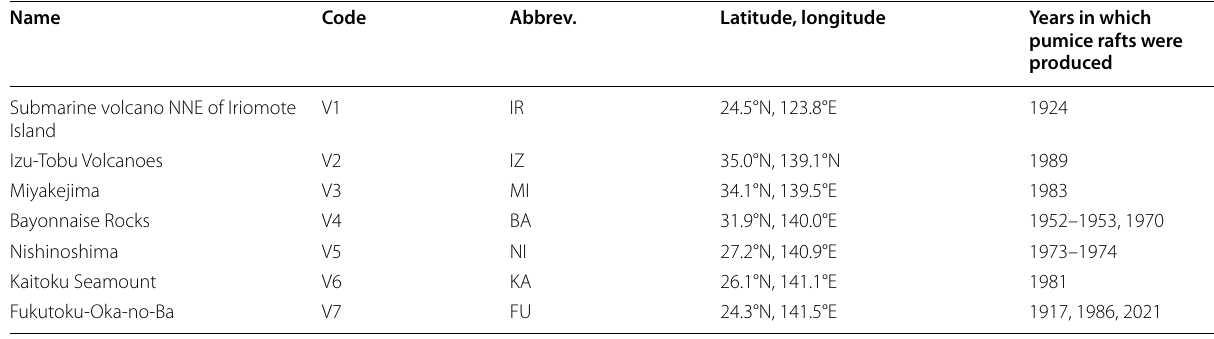
Table 2 Volcanic island and submarine volcano pumice sources used in this study. Descriptions are based on Ossaka (1991)